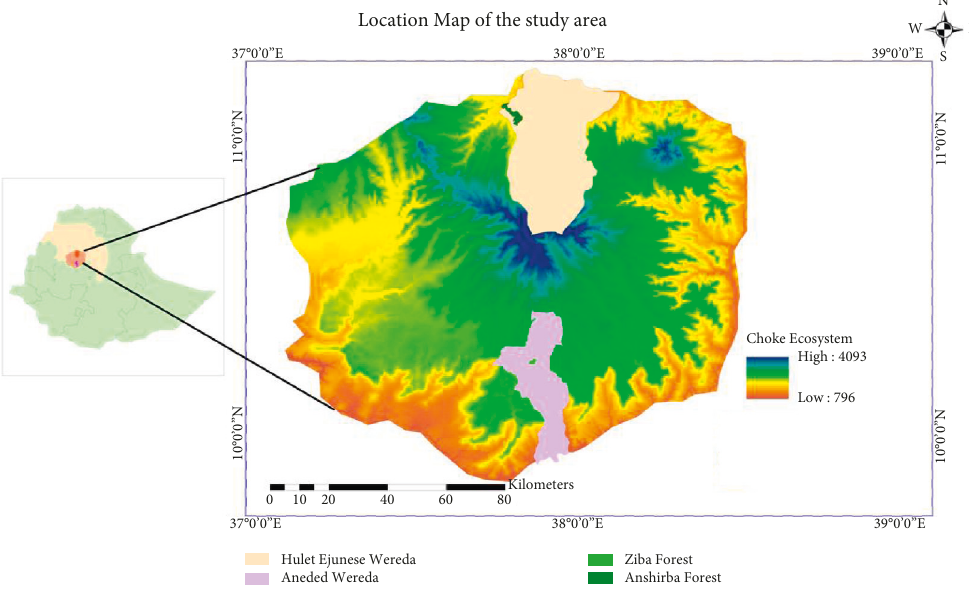
Figure 1: Location map of Choke Mountain